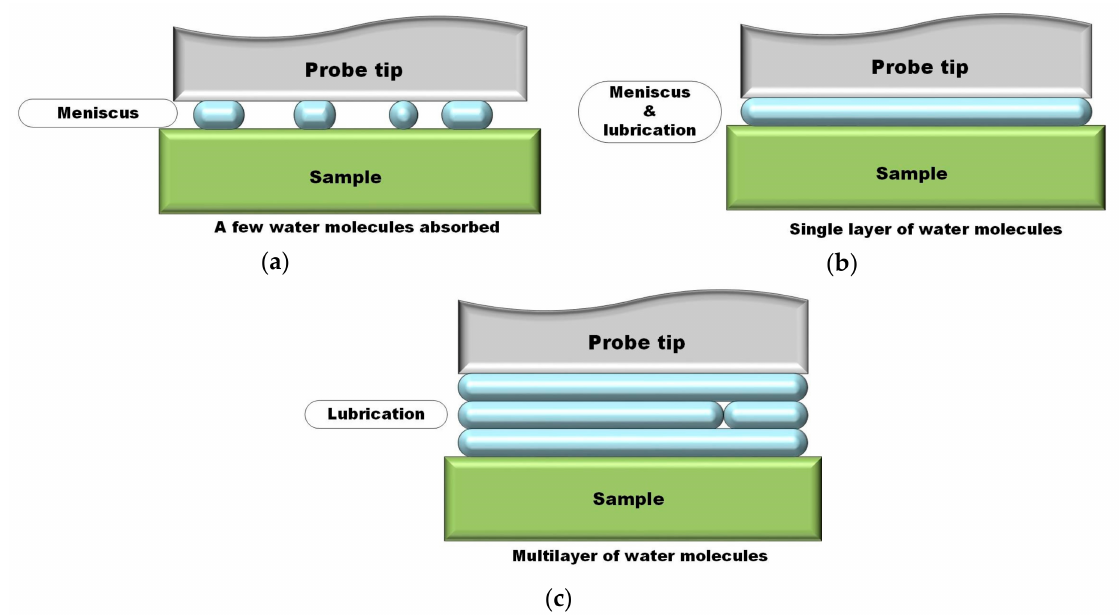
Figure 18. The e ff ect of water molecules between contact surfaces in nanotribological